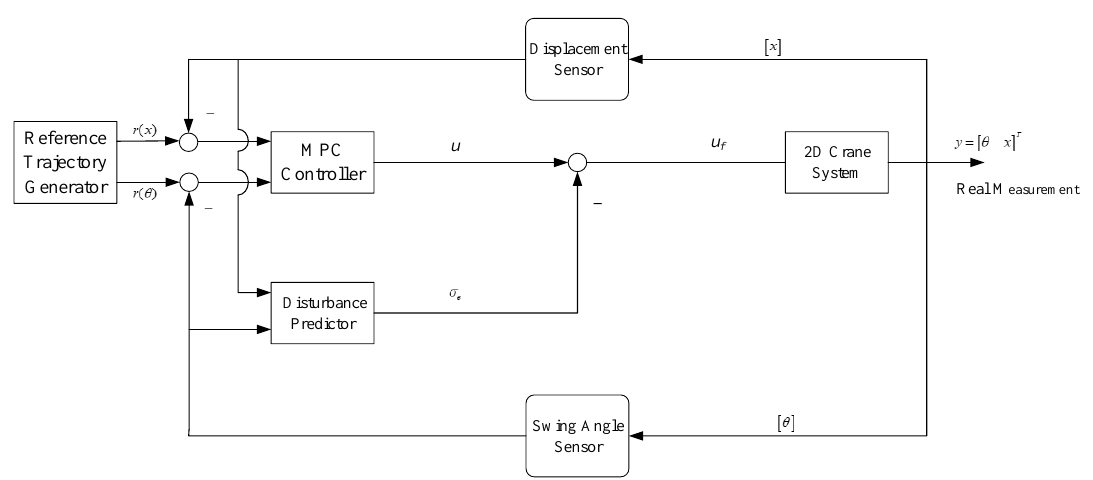
Figure 3. The block diagram of the proposed closed-loop control system.